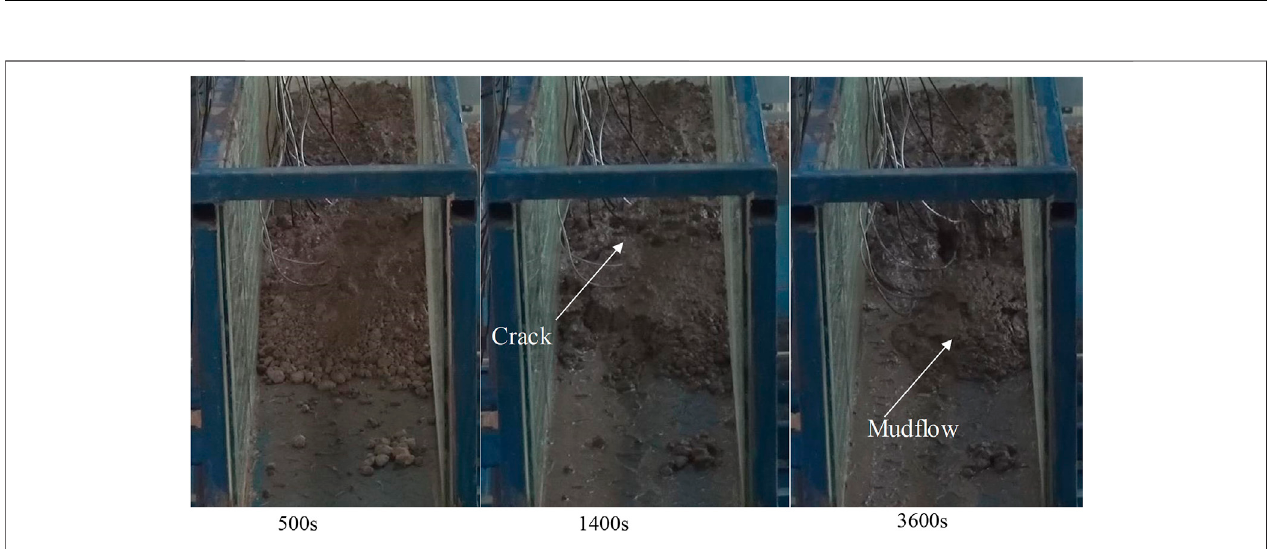
FIGURE 9 | Failure process in the experiment with a slope angle of 17 ° .